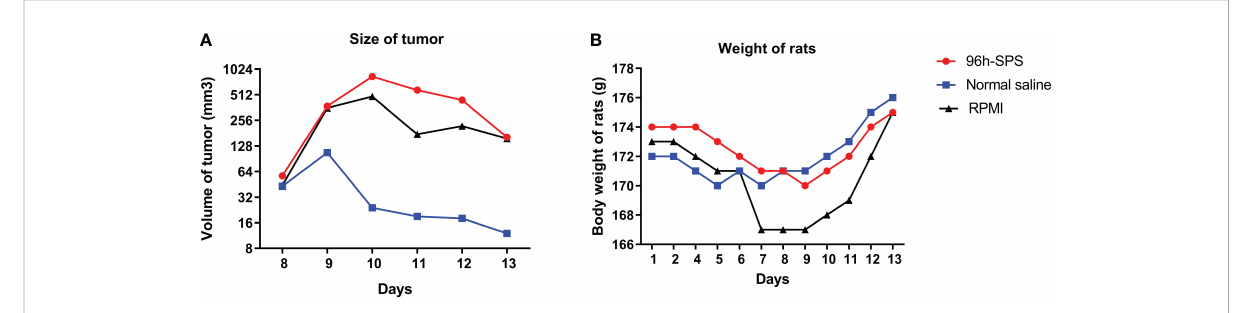
FIGURE 4 Tumor sizes and rats total body weights. (A) The size of tumors at different time points and (B) rat ’ s total body weight in all groups.